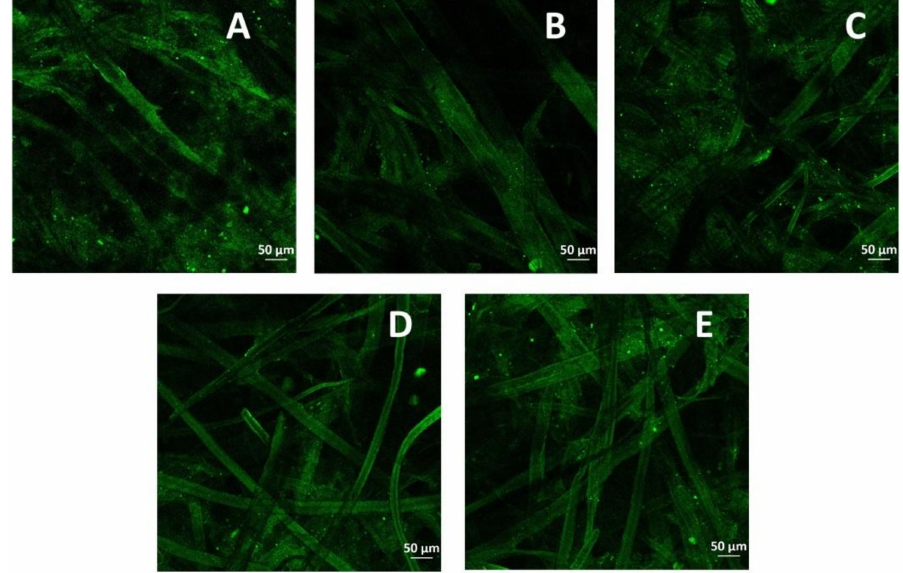
Figure 2. ( A ) SCEM (Scanning Confocal Electron Microscopy) blank; ( B ) SCEM for 1,2–DHB; ( C ) SCEM for vanillic acid; ( D ) SCEM for gallic acid–CPX; ( E ) SCEM for gallic acid–CPX. Scale indicates 50